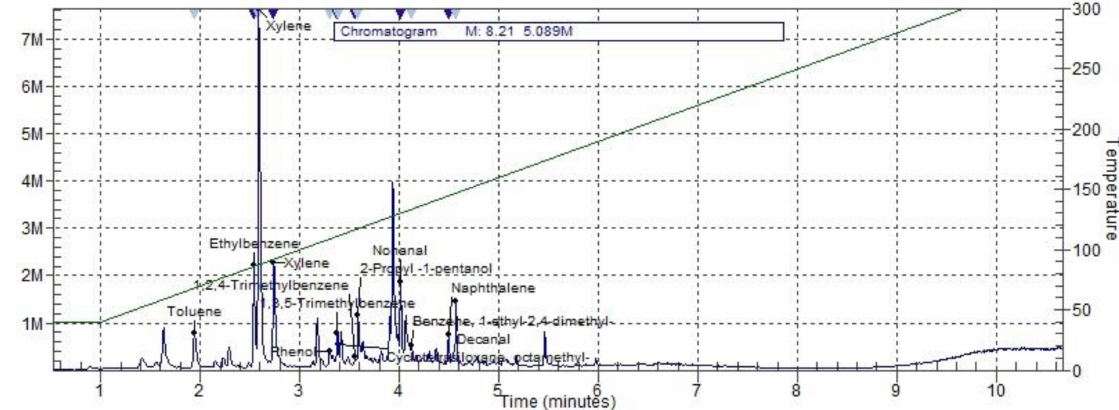
Figure 9. Example of a total ion chromatogram (TIC) with styrene free co-polyester (NGEN) filament. A comparison of the qualitative analysis with NGEN and PETG filaments is shown in Table 3 (YES indicates the identification/presence of the given compound in the analysis of the air in the test chamber at the indicated extruder temperature). The comparison of relative values of Quant Ion intensity rises with the increasing extruder temperature are presented in Supplementary Materials (see Figures S5 and S7). Table 3. Comparison of qualitative analysis during three-dimensional (3D) printing with styrene free co-polyester (NGEN) and polyethylene terephthalate (PETG)